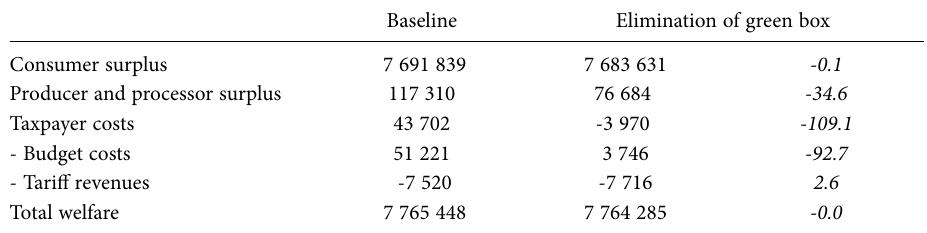
Table 6. Decomposition of welfare for the agricultural sector of the EU in 2020 by interest group and type of scenario (mio Euro, percentage change compared to baseline in italics).